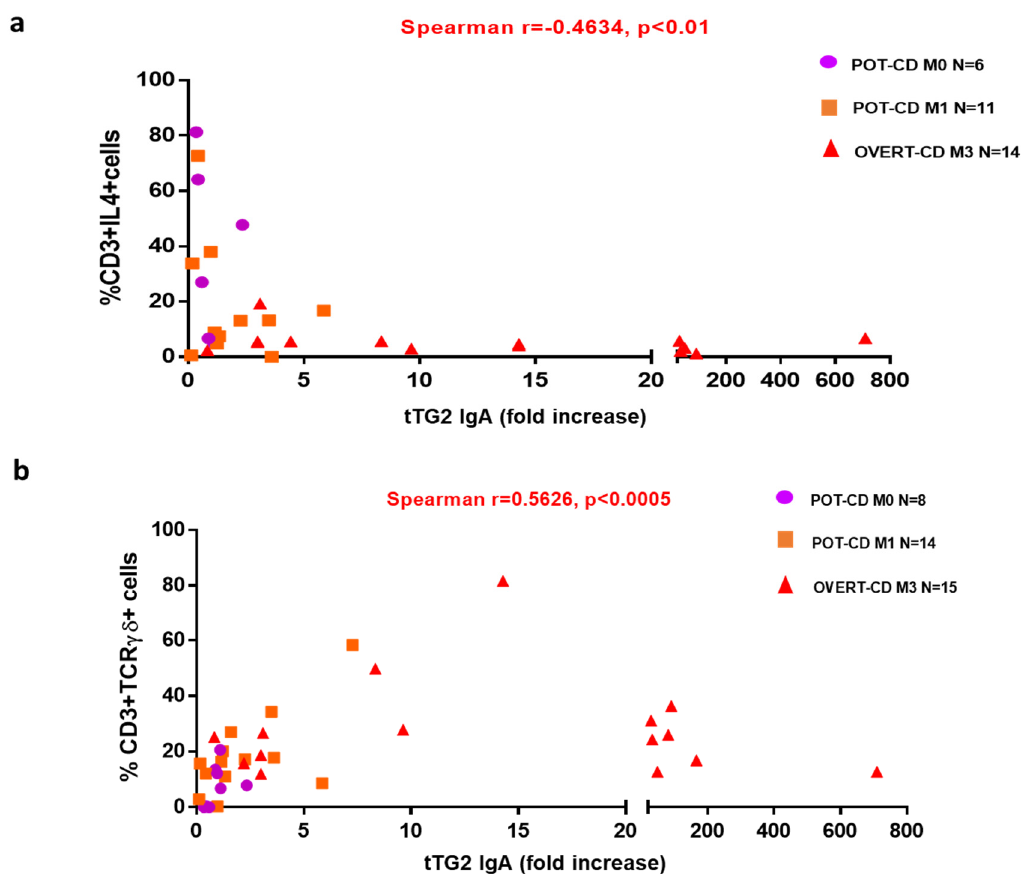
Figure 3. Correlation between the frequency of IL4+ T cells and TCR γδ + T cells with serum levels of anti-tTG2-IgA antibody. ( a ) The correlation between the percentage of IL4+ T cells and ( b ) TCR γδ + T cells and the serum anti-tTG2 levels was calculated in overall 37 CD patients grouped in potential-CD (M0), potential-CD (M1) and overt-CD (M3). The anti-tTG2 IgA levels (U/mL) were evaluated as fold increase respect to the specific threshold value indicated in the commercial kits, that were as follows: >7 U/mL by immunoenzymatic assay and >30 U/mL by chemiluminescent immunoassay. The correlation was assessed using the non-parametric Spearman’s rank correlation coefficient by GraphPad Prism Software, with a p ≤ 0.05 considered statistically significant.